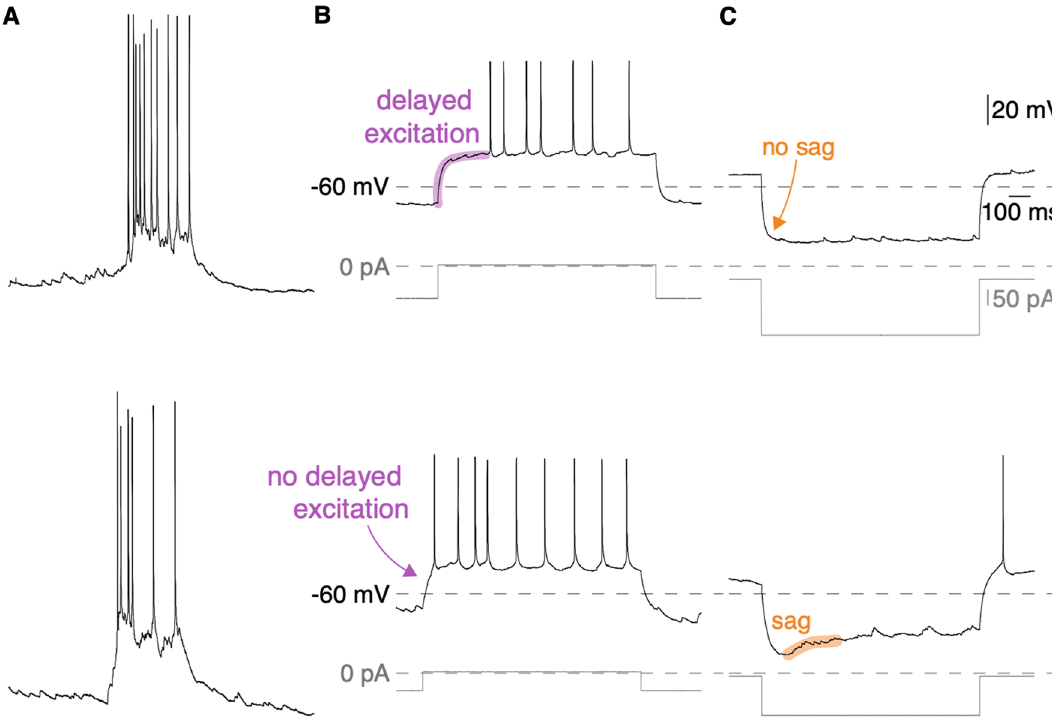
Figure 1. Physiological properties of Dbx1 preBötC inspiratory neurons. ( A ) top and bottom traces show inspiratory burst characteristics in Type-1 and Type-2 Dbx1 preBötC neurons, respectively. ( B ) Depolarizing current pulses (750–1000 ms) were applied from a membrane potential of − 70 mV. Top and bottom traces show presence and absence of delayed excitation (purple) in Type-1 and Type-2 neurons, respectively. ( C ) Hyperpolarizing current pulses (750–1000 ms) were injected from a membrane potential of − 50 mV. Top and bottom traces show absence and presence of a sag potential (orange) in Type-1 and Type-2 neurons, respectively. Voltage, current, and time calibration bars apply to all